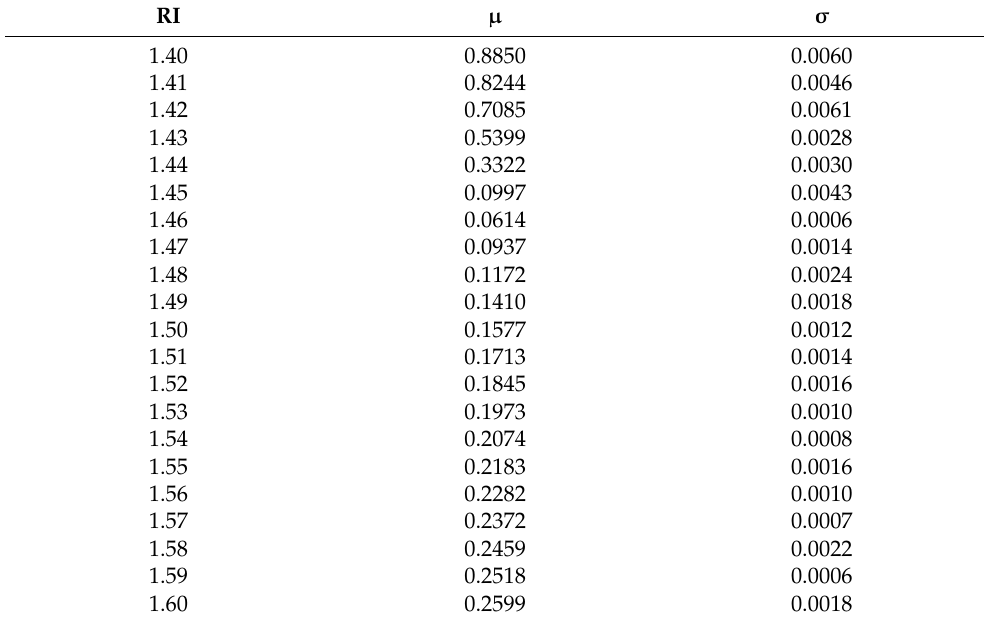
Figure 7. Cubic spline interpolation curves of the average and upper and lower standard deviation values in the RI range ( a ) 1.40–1.46 and ( b ) 1.46–1.60. Table 1. Values of the mean and standard deviation for the 10 set points at each RI. RI